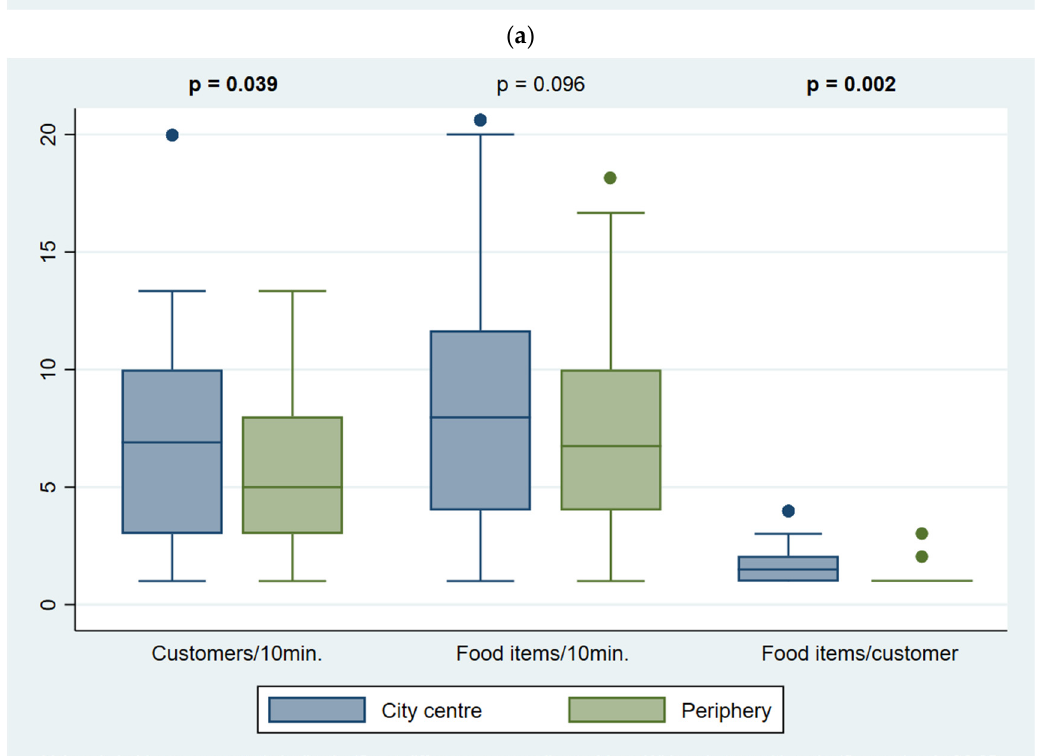
Figure 2. Customer influx, food items buying rate and number of food items purchased per customer, in ( a ) street food and ( b ) takeaway food vending sites, by city location.